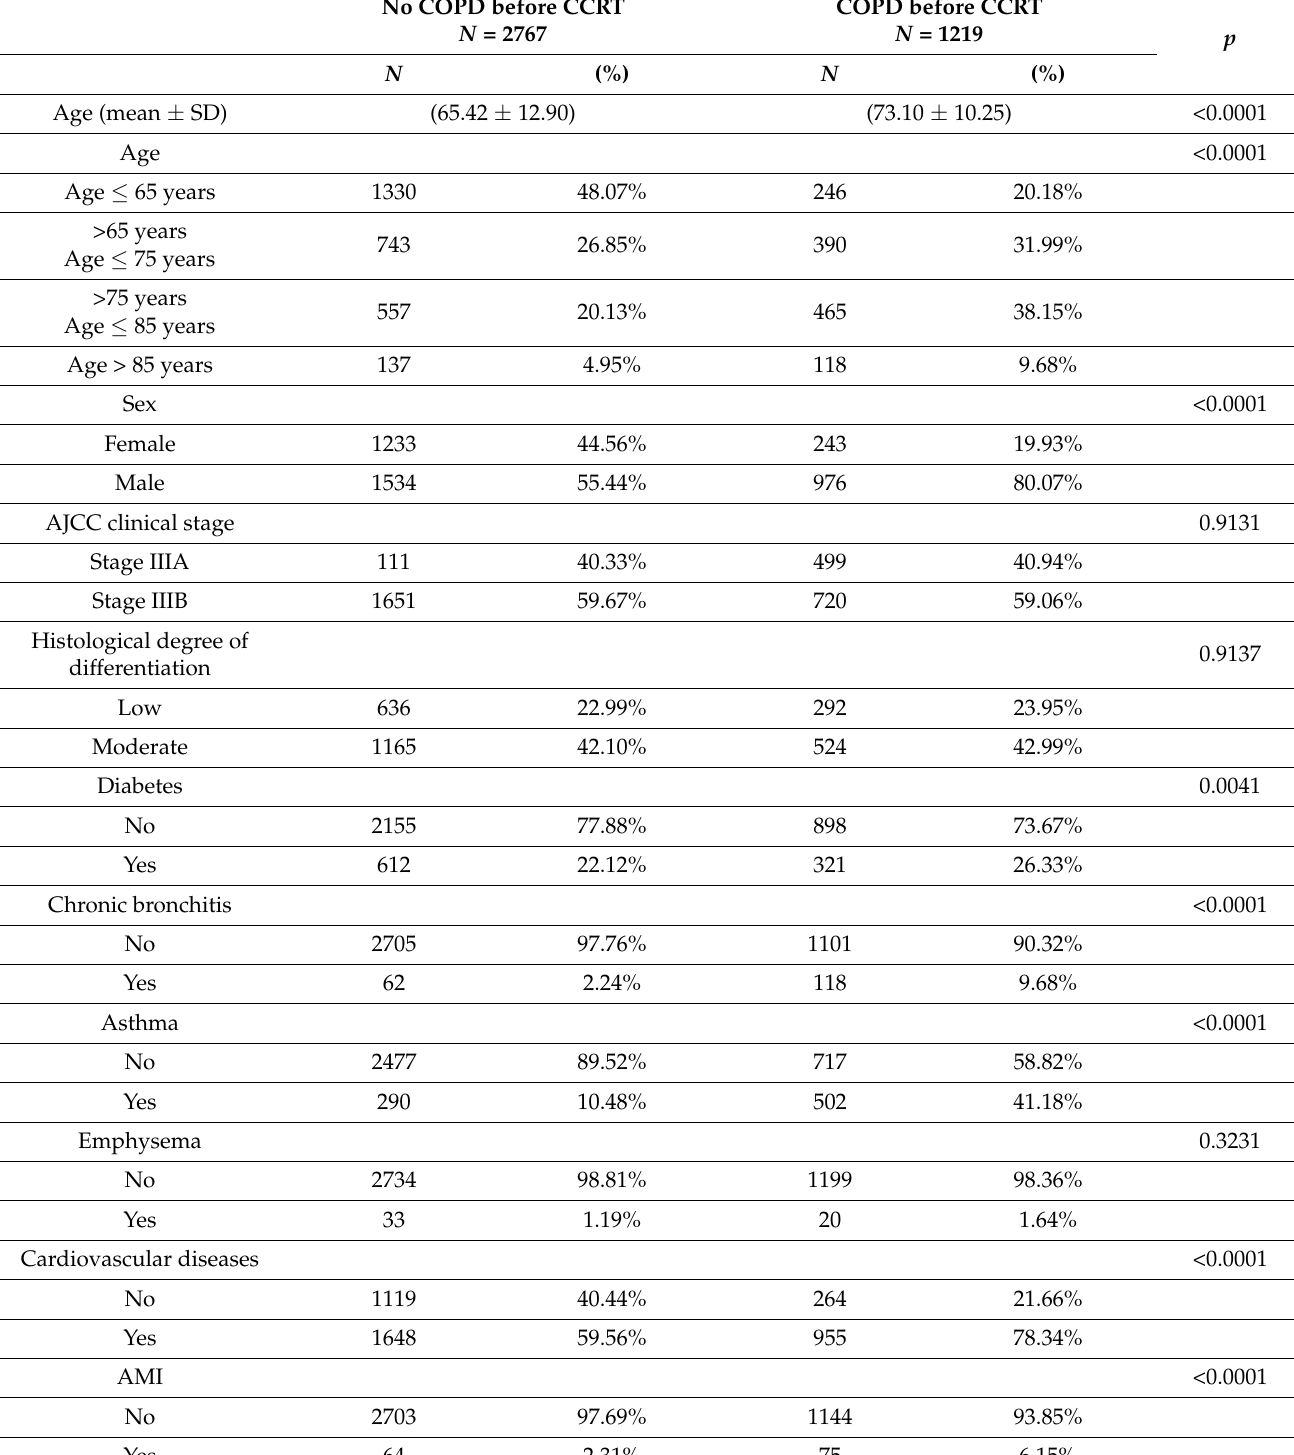
Table 1. Characteristics of patients with advanced stage lung squamous cell carcinoma with or without chronic obstructive pulmonary disease before concurrent